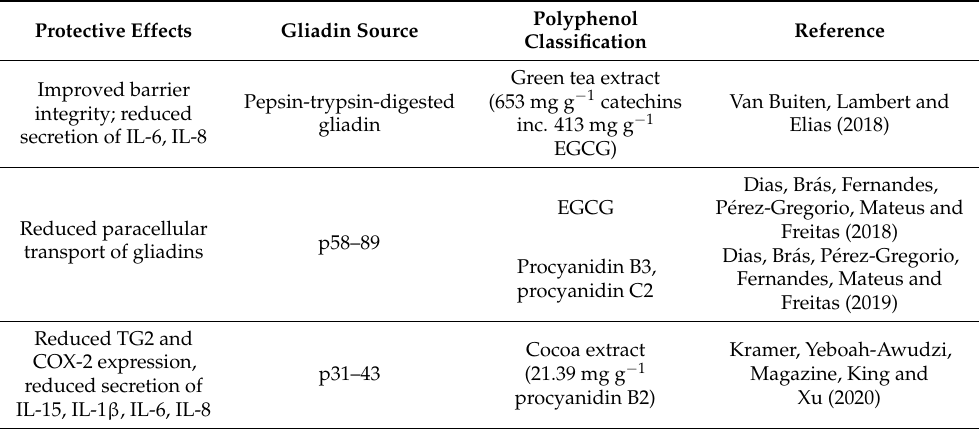
Table 2. Effect of polyphenols on gliadin-mediated inflammation and damage in vitro using Caco-2 cells as a model for celiac